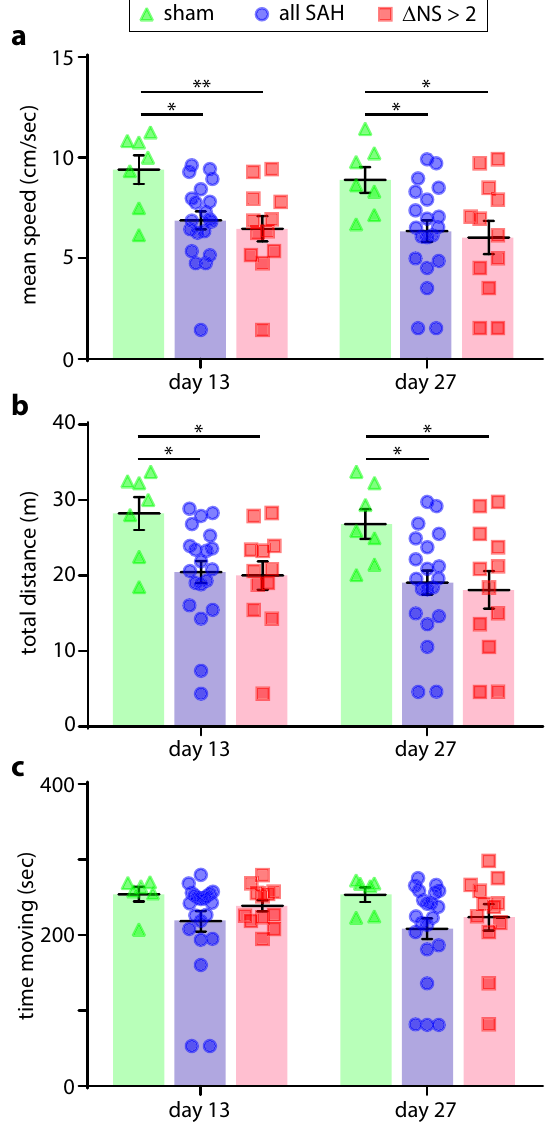
Figure 3. General activity assessments. Assessment of mean speed ( a ), total distance ( b ), and time spent moving ( c ) during passive exploration in the open field test at 13 and 27 days post-injury. t-test with Holm- Bonferroni correction for multiple comparisons ( a ). Mann-Whitney U test with Holm-Bonferroni correction for multiple comparisons ( b , c ). Time moving before correction for multiple comparisons; day 13 P = 0.17 sham vs. all SAH, P = 0.48 sham vs. Δ NS > 2; day 24 P = 0.05 sham vs. all SAH, P = 0.34 sham vs. Δ NS >